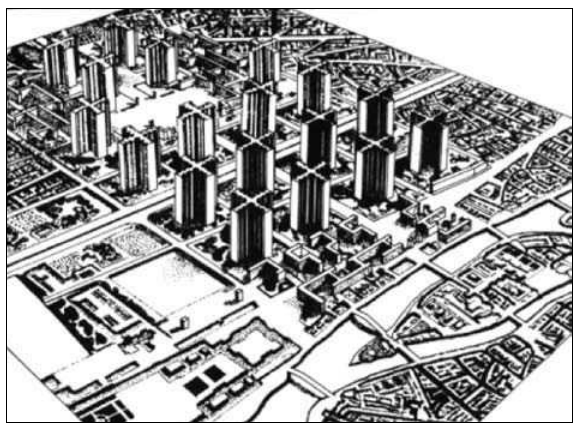
Fig. 3. reconstruction Plan of Paris central district,